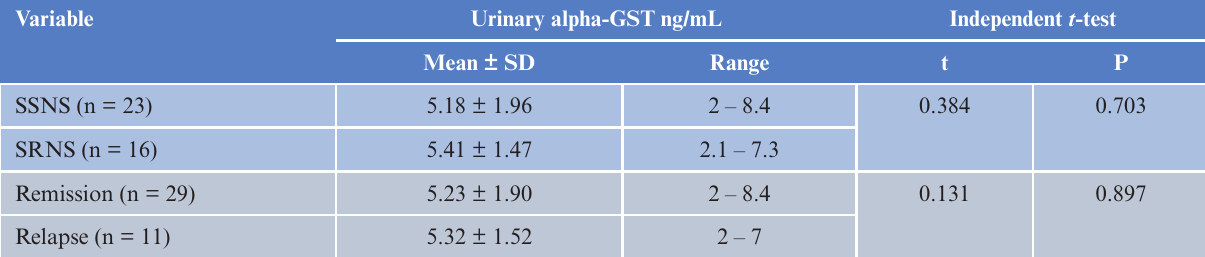
Table 3: Comparison between nephrotic syndrome clinical types with regard to urinary alpha glutathione S-transferase level.